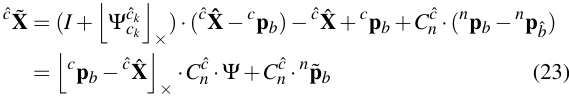
Figure 3: Position of a feature expressed in the true camera co- ordinate system c k and the estimated camera coordinate system ˆ c k